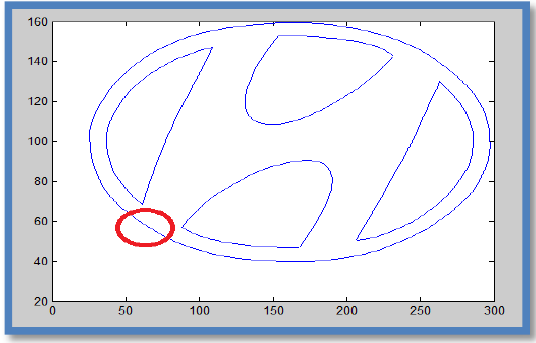
Fig. 7. Continuity example through two curves of C 2 Bezier techniques.